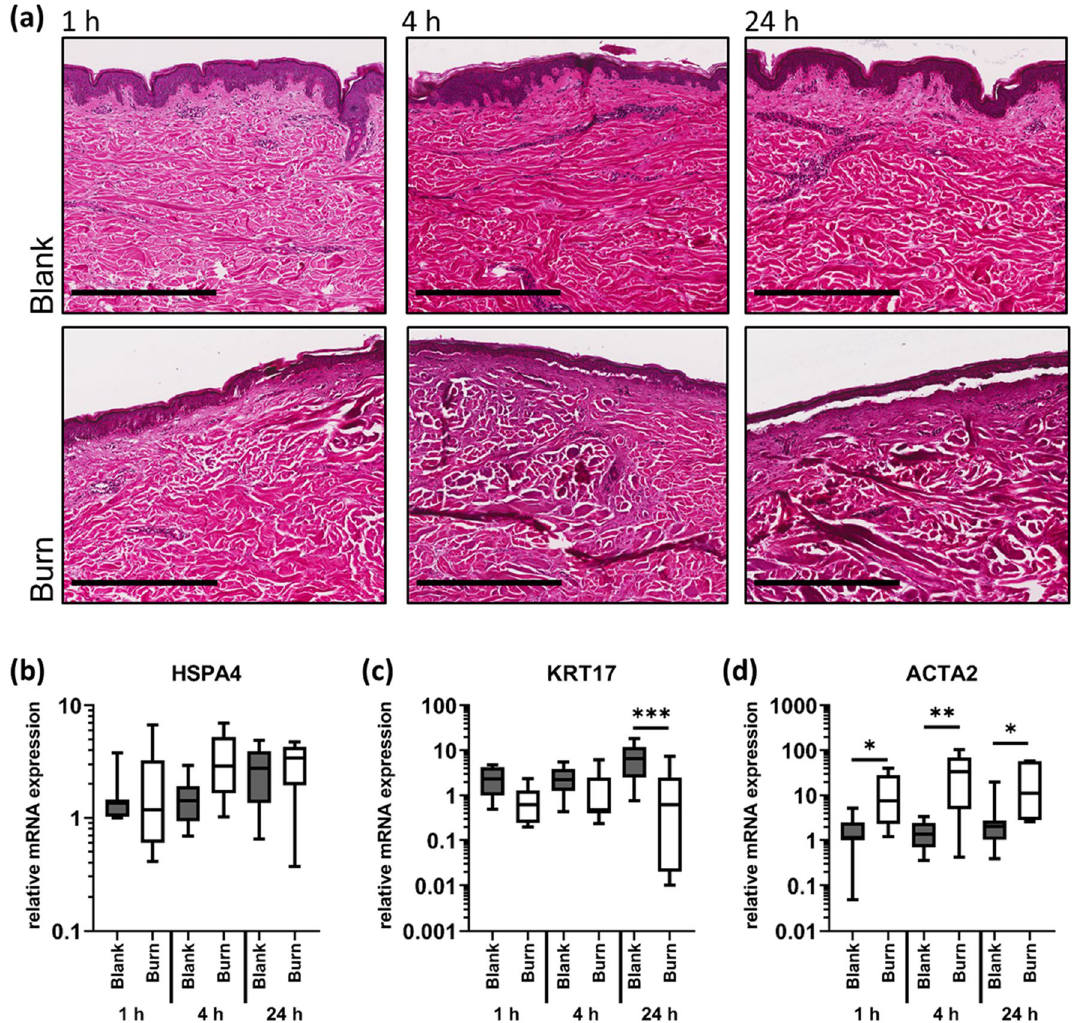
Figure 2. Partial thickness burns affect the expression of HSPA4, KRT17 and ACTA2. Contact burn injuries were created on fresh human skin explants by applying a heated metal block (100 °C). Biopsies were collected after 1, 4 and 24 h. ( a ) Histology confirmed a partial thickness burn pathology. Scale bar = 500 µm. Relative mRNA expression levels of ( b ) HSPA4, ( c ) KRT17, and ( d ) ACTA2 were determined by RT-qPCR, normalizing target gene expression to the averaged expression of RPLP0 and TBP. Data are presented as median (line) the interquartile range (box) and the minimum and maximum values (whiskers) from three individual skin explants. P-values < 0.05 were considered as statistically significant with *, **, *** indicating p < 0.05, p < 0.01, and p < 0.001, respectively (dependent on normal distribution ANOVA or Kruskal–Wallis Ultrastructural analyses showed that the stratum corneum detached from the other epidermal layers upon burn injury. Epidermal structures were condensed (Fig. 3d–f) compared with blank skin (Fig. 3a–c). While the basement membrane separates the stratum basale from the dermis in healthy skin, such structures were hardly detectable in burnt skin areas. Burn injury increased the expression of factors involved in angiogenesis and remodeling, such as the tran- scription factor HIF1A and its target genes VEGFA, CXCL12 and FGF2, soon after injury (Fig. 4a–d). Expression levels of CXCL12 and FGF2 remained increased at burn sites until 24 h after burn injury (Fig. 4c,d). LEP expres- sion levels remained unaffected 1 and 4 h after the burn injury but were significantly increased after 24 h (Fig. 4e).